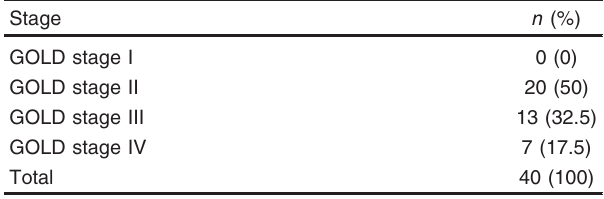
GOLD, Global Initiative for Chronic Obstructive Lung